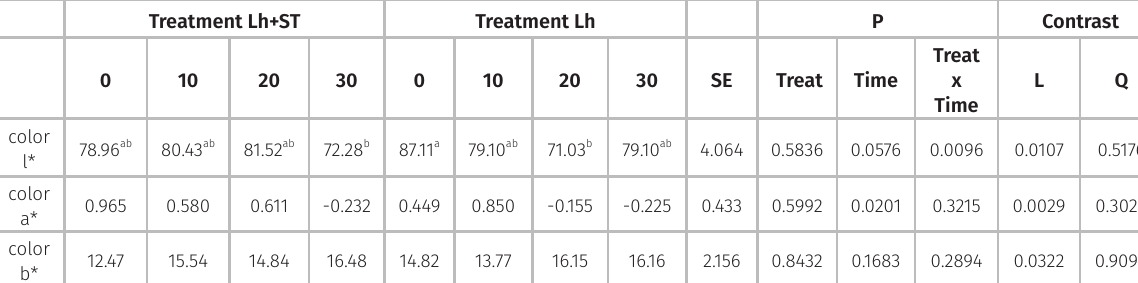
Table VI. Instrumental colors of ripened cheese. Treatment